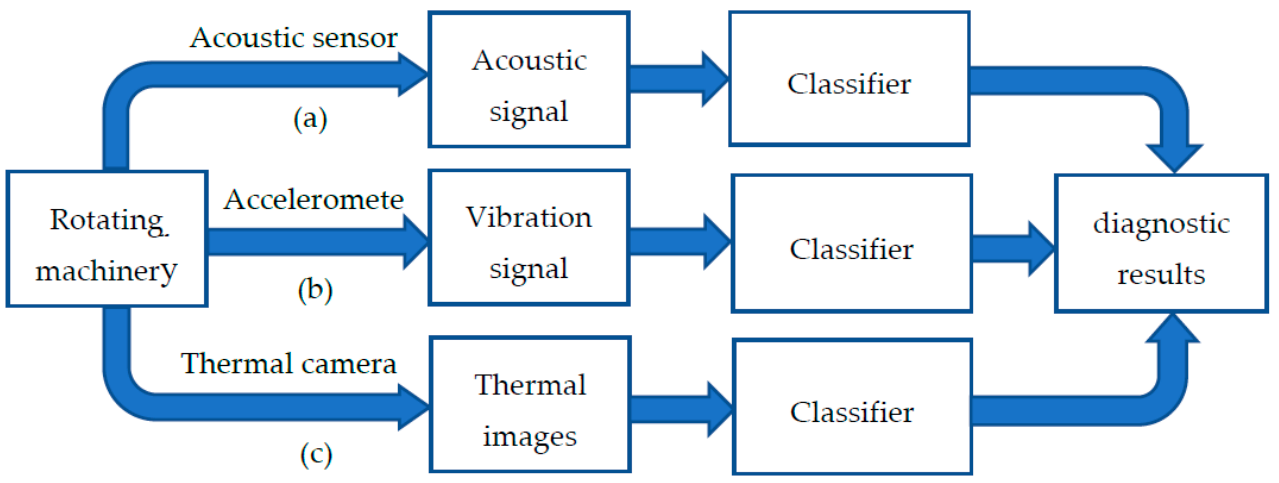
Figure 1. Three methods for fault diagnosis: ( a ) Acoustic analysis; ( b ) Vibration analysis (the proposed method); ( c ) Thermal images analysis.